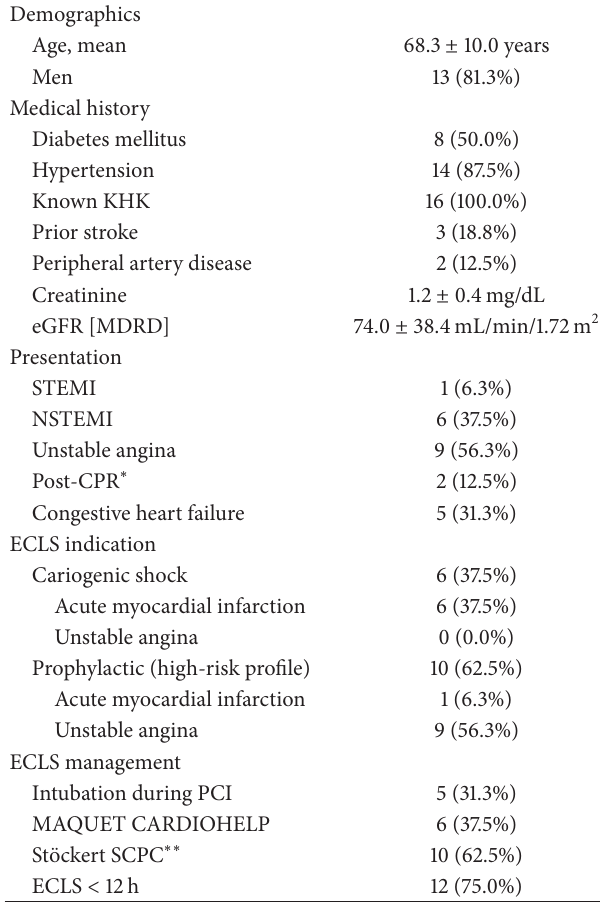
Table highlighting patients’ characteristics of all patients undergoing LMCA PCI with ECLS backup. ∗ Cardiopulmonary resuscitation (CPR) prior